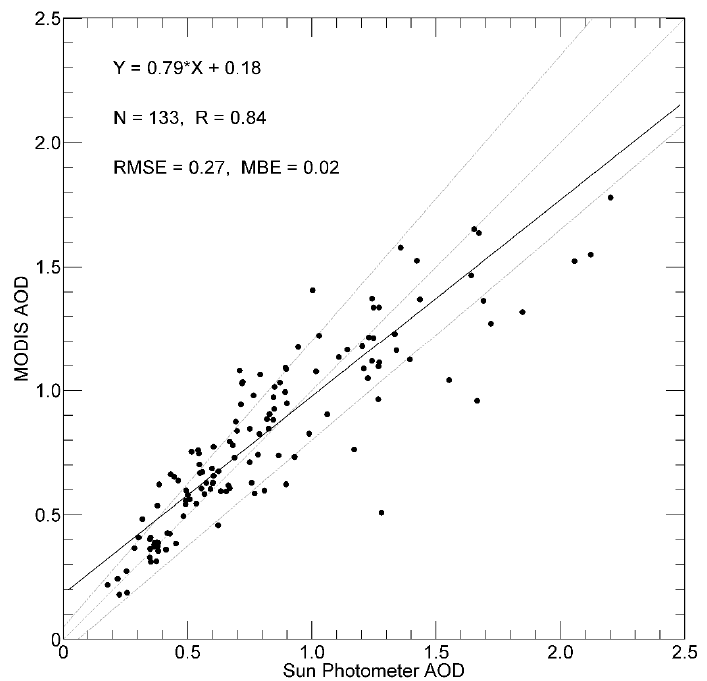
Figure 6. Scatterplots with the sun photometer AODs and Aqua MODIS 3 km DT AODs with all quality. The solid line is the linear regression line. The texts are some evaluation metrics. The gray dashed lines are the expected errors (EE) of ±(0.05 + 15%) and 1:1 line.